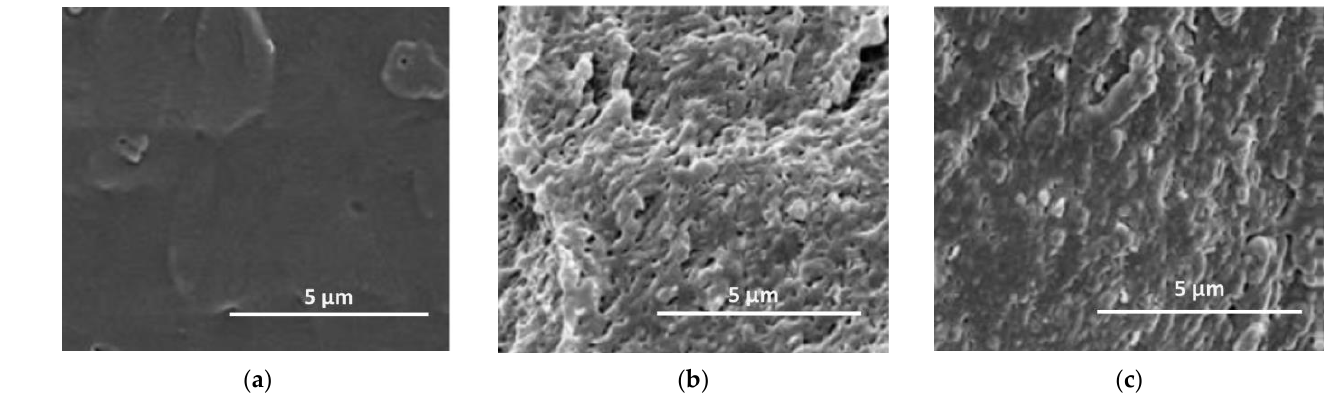
Figure 6. SEM images of ( a ) neat PLA, ( b ) PLA/DFR, and ( c ) PLA/RFW.